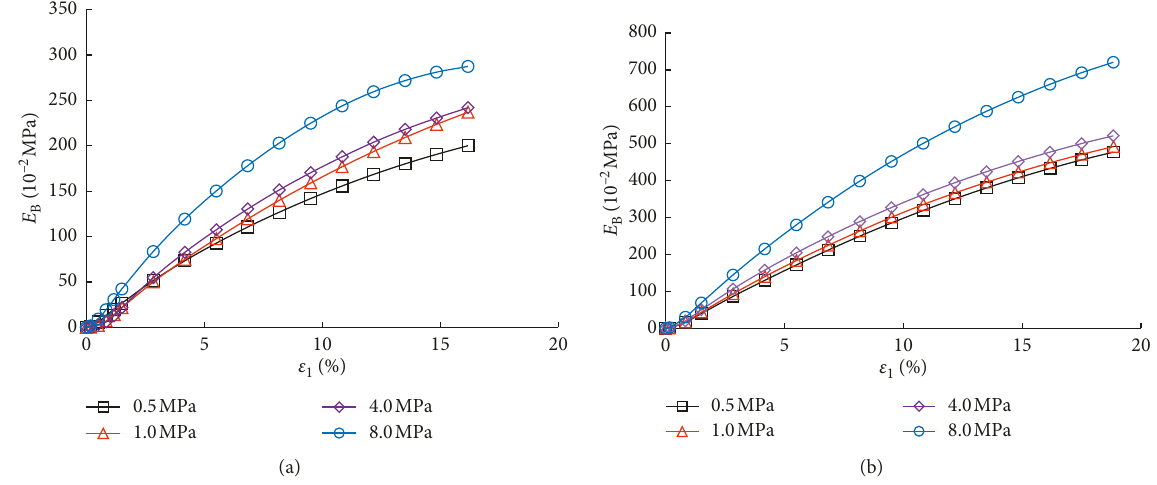
Figure 6: Relation curve of energy consumption of particle breakage and shear strain. (a) T � − 3 ° C. (b) T � − 5 °